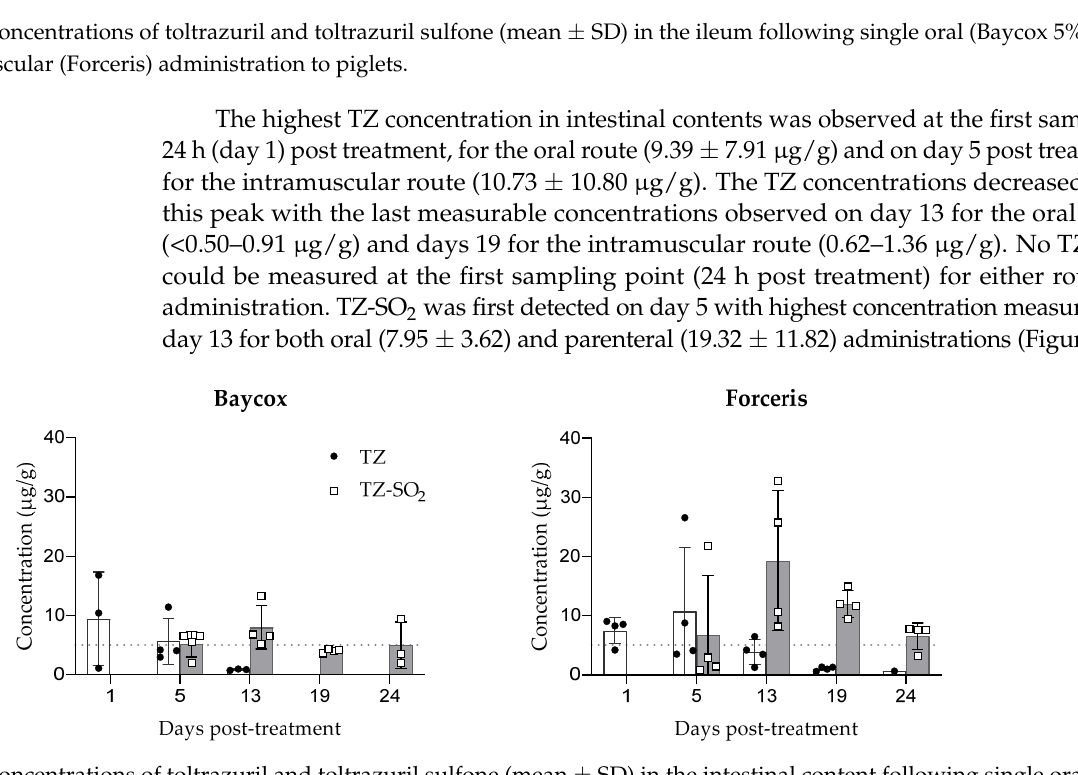
Figure 3. Concentrations of toltrazuril and toltrazuril sulfone (mean ± SD) in the ileum following single oral (Baycox 5%) or intramuscular (Forceris) administration to piglets.